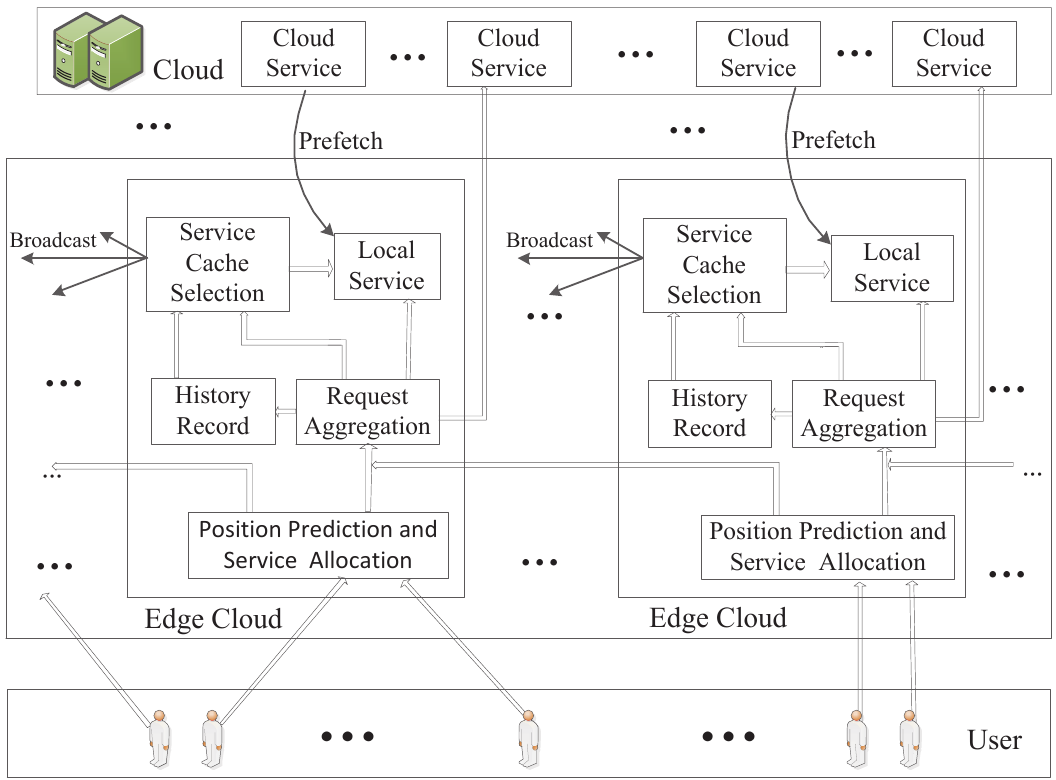
Figure 3. The System